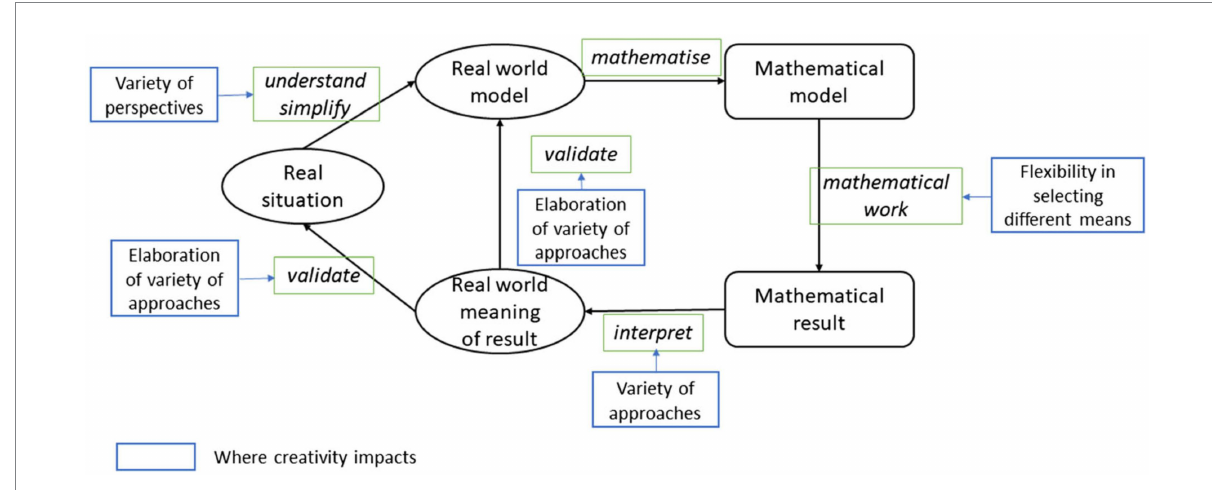
FIGURE 1 Modeling cycle enriched by aspects of creativity (Lu and Kaiser, 2022a) (CC-BY)